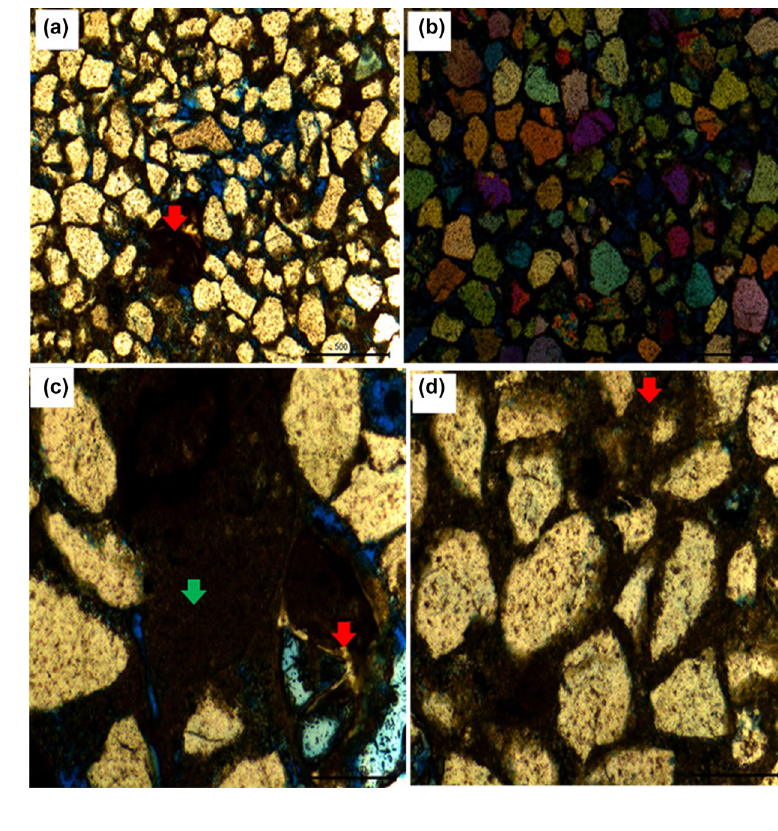
Fig. 7 SEM images of repre- sentative photomicrographs of massive medium-grained sandstone (MMGS) showing different pore types: ( a ) grain shapes, sorting/packing, ( b ) fine-grained matrix fraction obliterating intergranular pores, ( c ) fine-grained clogging pore throat and ( d ) fossil shell frag- ment filled with fine matrix indicated by red